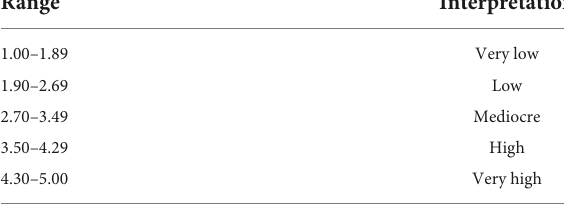
TABLE 1 Minimum score of interpretation by scale.